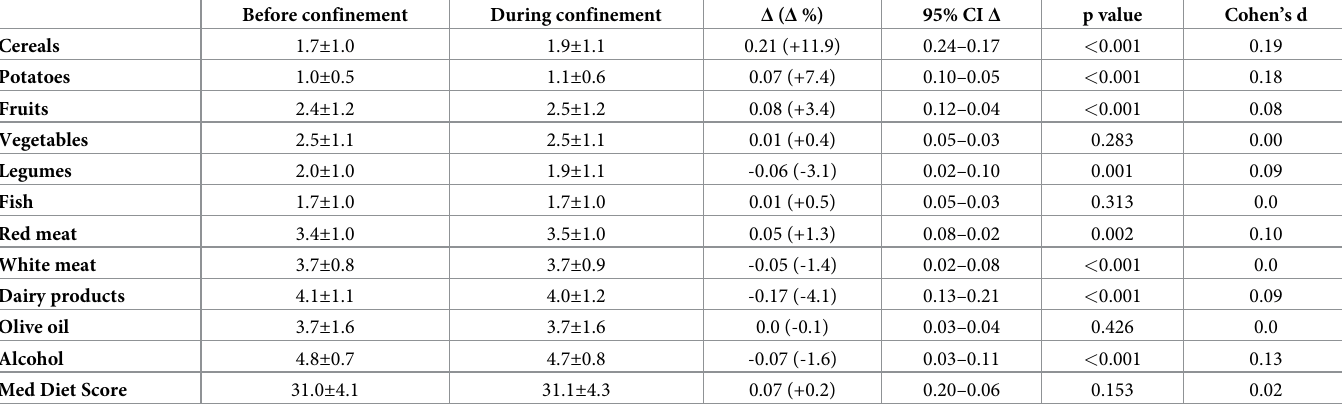
Data are shown in a score range from 0 to 5 according to their position in the Mediterranean diet pyramid. The Med Diet Score is the sum of all items in the same column.